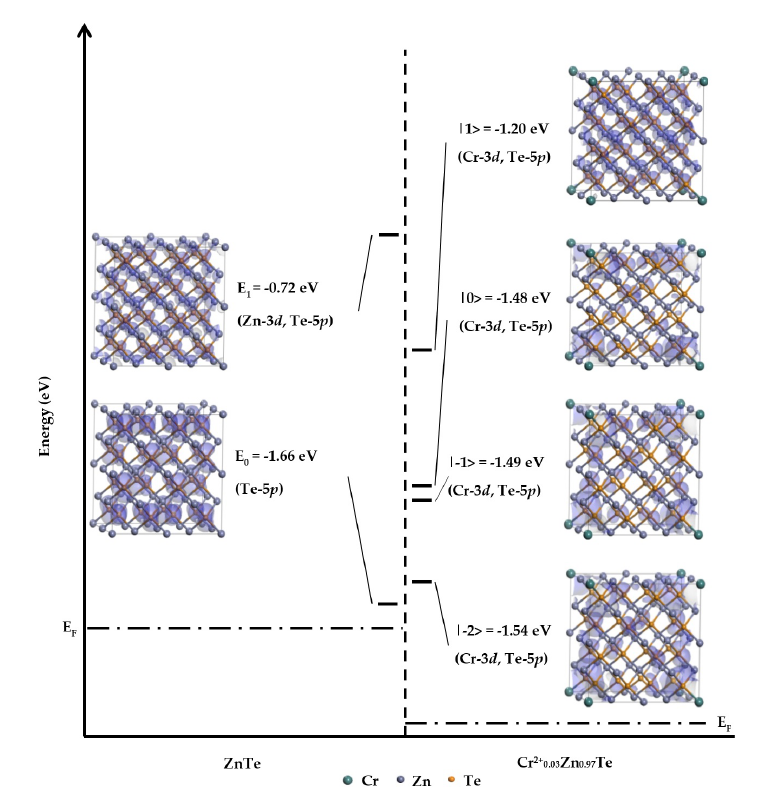
Figure 6. Left (Right) panel: HOMO and LUMO slab isosurfaces of 64-atom ZnTe (Cr 2 + 0.03 Zn 0.97 Te) cells arranged by energy and denoted by the shade of purple. The atoms are represented by spheres: Cr (green), Zn (gray, dark), and Te